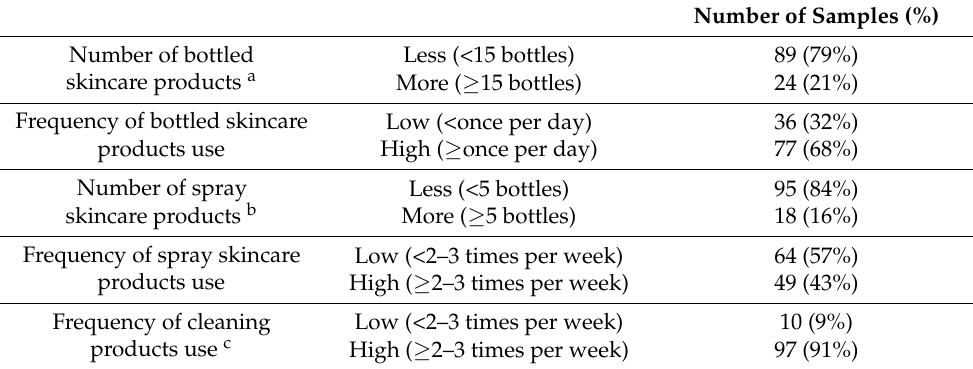
Table 2. Personal care products.